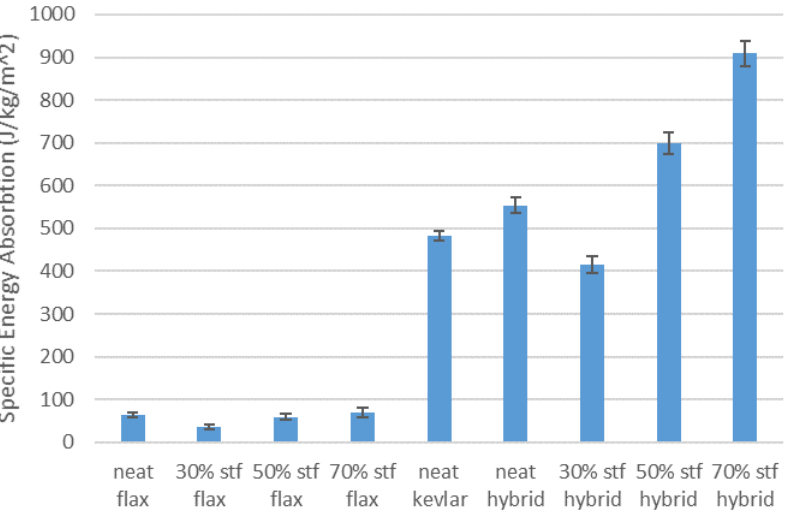
Figure 11. Comparison of specific ballistic impact energy absorption per layer.